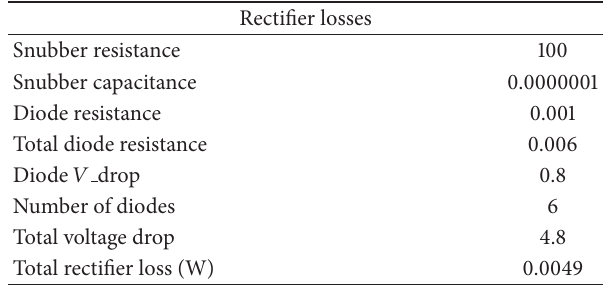
Table 1: Piezoelectric material properties.